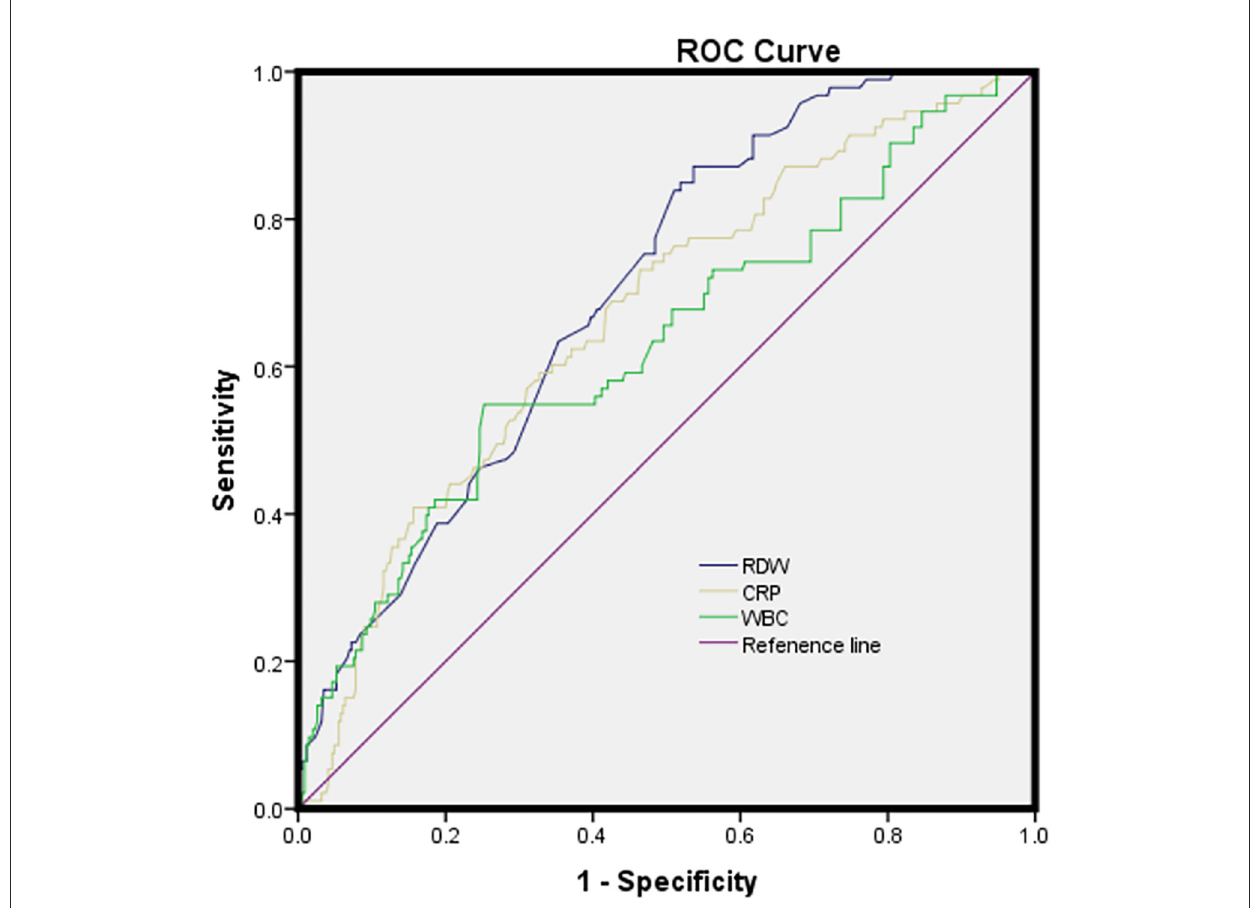
FIGURE2 The ROC curves for the prediction of post-ICH depression. Predictive values of RDW, CRP, and WBC for depression at 3 months after ICH: AUC of 0.669 (95%CI, 0.607-0.730; p < 0.001) for CRP; 0.631 (95% CI, 0.564–0.698; p < 0.001) for WBC; and 0.703 (95% CI, 0.649–0.757; p < 0.001) for RDW; RDW had a COV of 13.68, and the sensitivity and specificity were 63.4% and 64.6%,